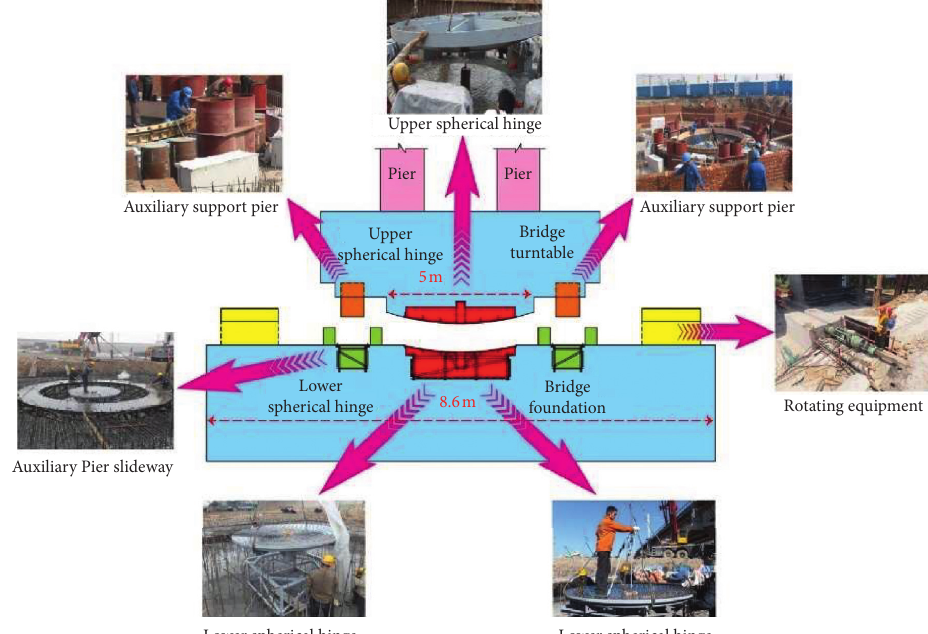
Figure 1: Main structure of a horizontal rotation